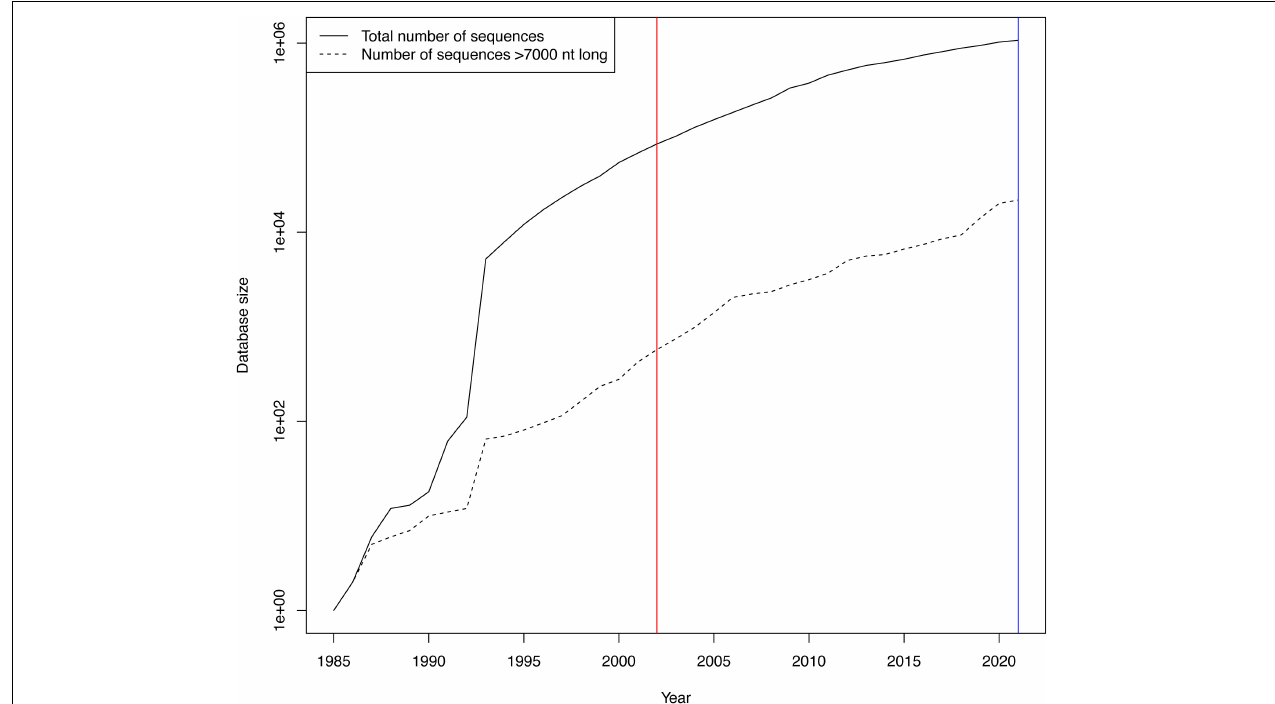
FIGURE 1 | Growth of HIV-1 sequences in the LANL HIV database. The growth of the number of publicly available HIV sequences has been roughly exponential since the beginning of the HIV era. The y-axis is logarithmic to make the near full genome ( > 7,000 nt) sequence count visible. The red vertical line shows when the last previous HIV consensus sequences were calculated in 2002, and the blue line when we calculated the new ones in this publication in 2021.